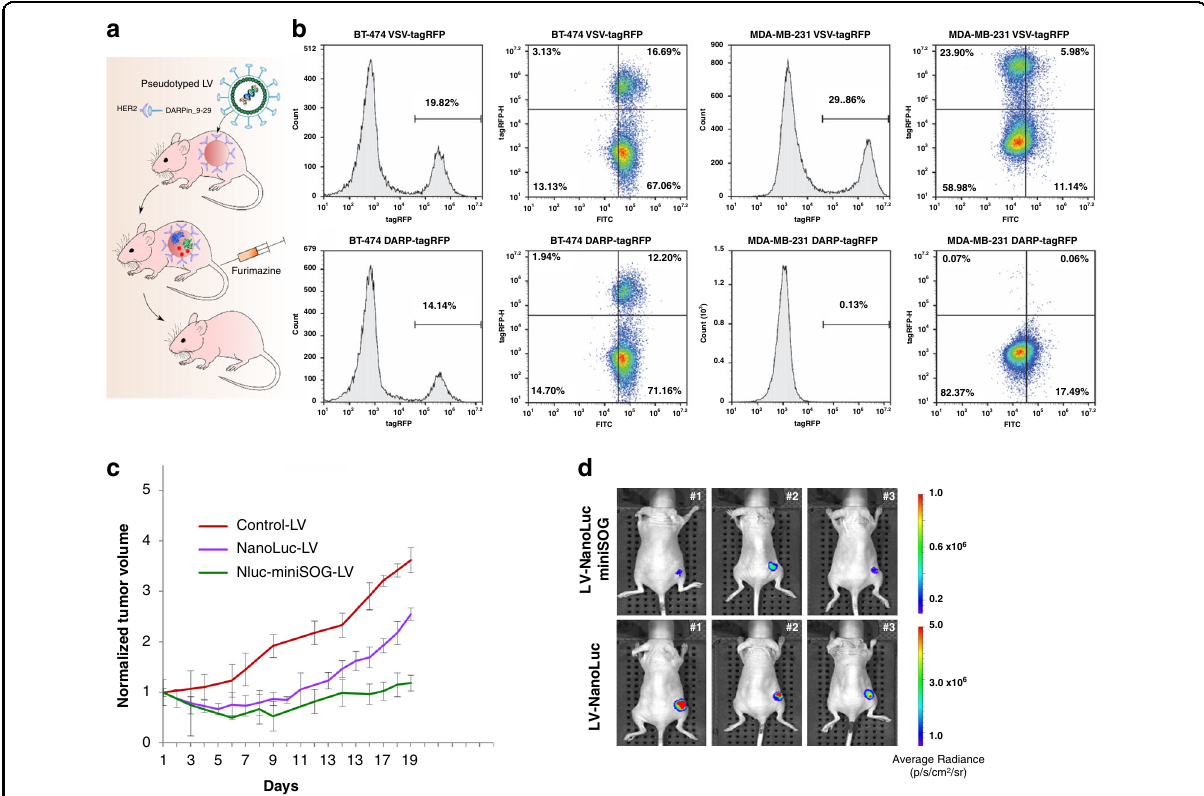
Fig. 4 Targeted PDT using HER2-speci fi c lentiviruses (LVs) as carriers of NanoLuc-miniSOG gene. a Schematic representation of experiment. HER2-positive tumor is targeted with HER2-speci fi c LVs carrying the NanoLuc-miniSOG gene. DARPin_9-29 incorporated in LV ’ s envelope targets LVs to HER2-speci fi c tumor. b Comparison of receptor speci fi city and transduction ef fi ciencies of VSV-pseudotyped and HER2-retargeted lentiviral vectors. Histograms demonstrate similar transduction ef fi ciencies of VSV-tagRFP LVs in HER2-positive and HER2-negative cell line, whereas DARPin_9-29- tagRFP LVs were able to exclusively transduce HER2-positive BT-474 cells. c Tumor-growth curves for control group (mice treated with PBS only), as well as for groups carrying NanoLuc or NanoLuc-miniSOG LVs particles and treated with furimazine. Data are presented as the mean ± SD ( n = 6). d